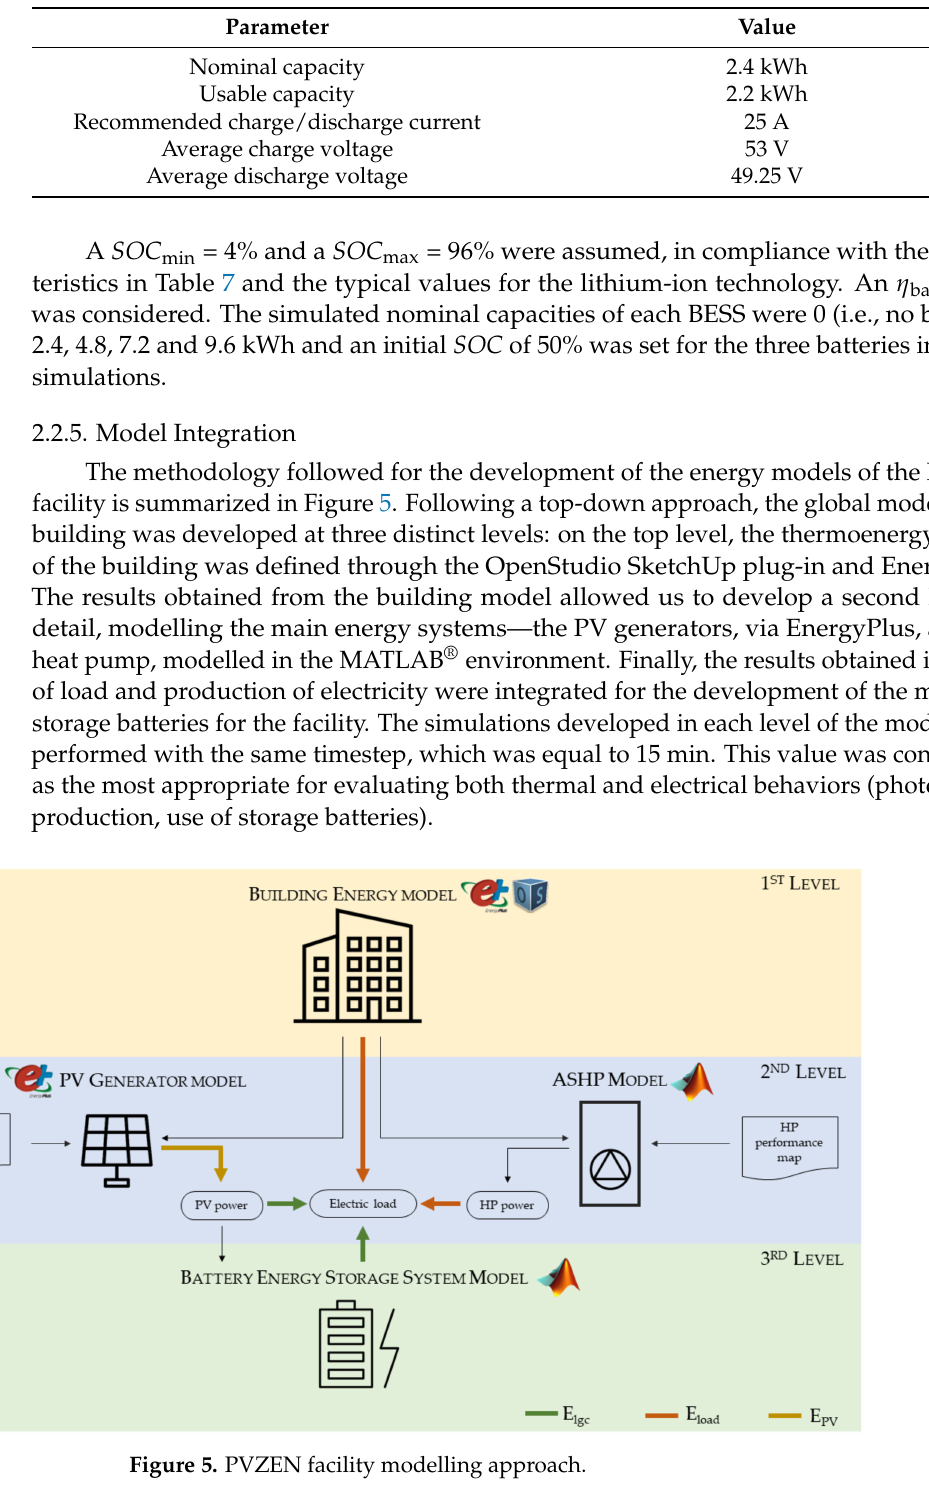
Table 7. Characteristics of one module of the selected lithium-ion battery.